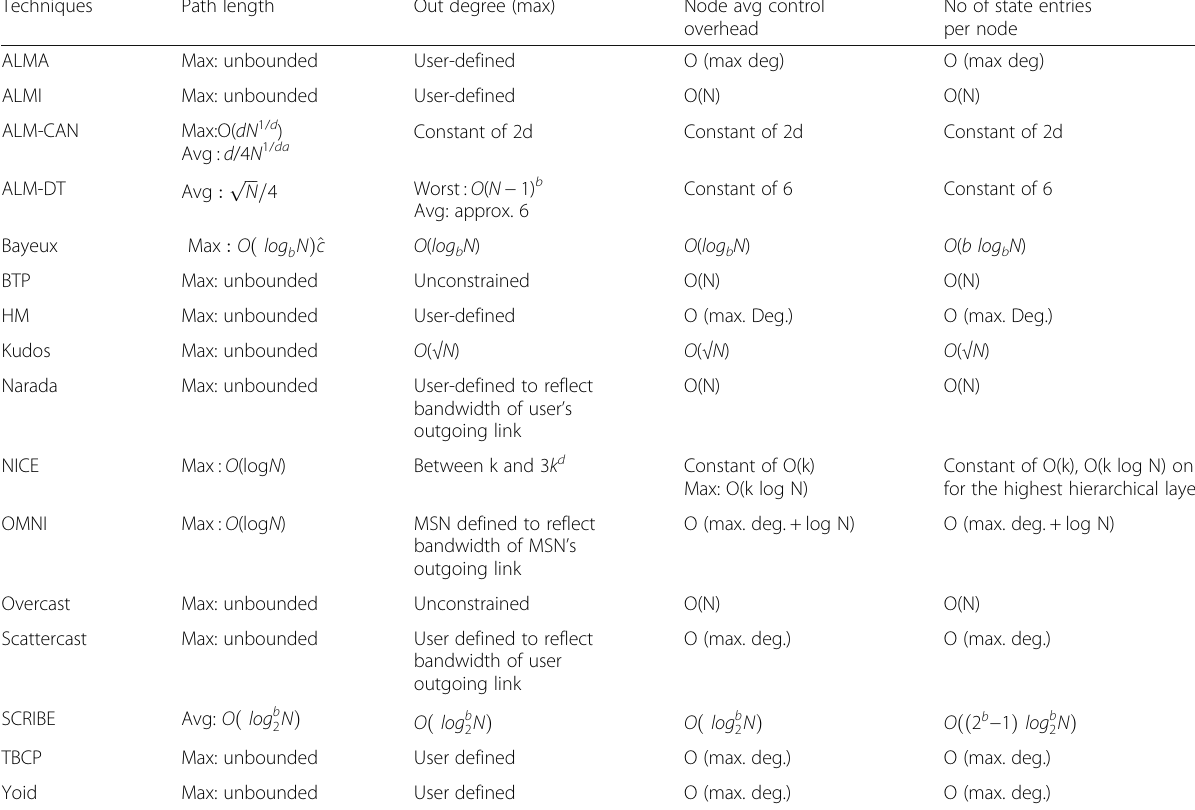
Table 7 Summarized various techniques and performances Techniques